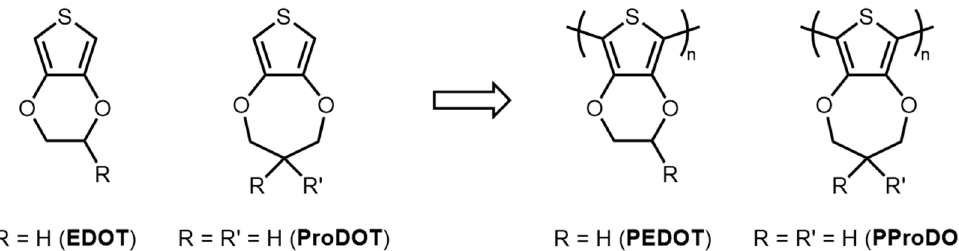
Figure 1. General monomer (left of arrow) and polymer (right of arrow) structures of 3,4-ethylenedioxythiophene (EDOT) and 3,4-propylenedioxythiophene (ProDOT) and their functionalized derivatives.